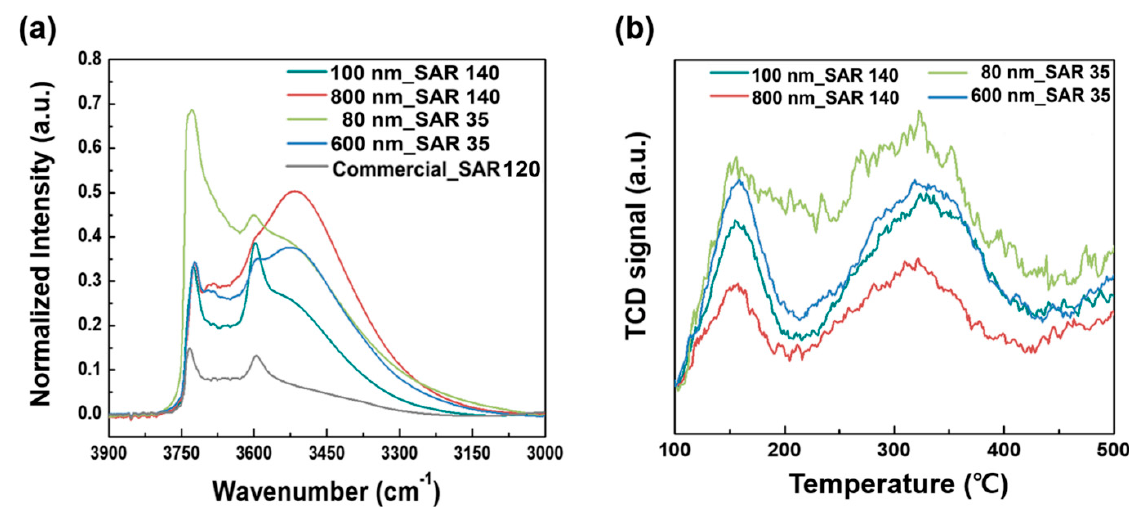
Figure 7. IR spectra and NH 3 -TPD results of Silicalite-1@Al-ZSM-5 and commercial zeolite (SAR = 120) samples before Mo impregnation. ( a ) FT-IR spectra and ( b ) NH 3 -TPD profiles.